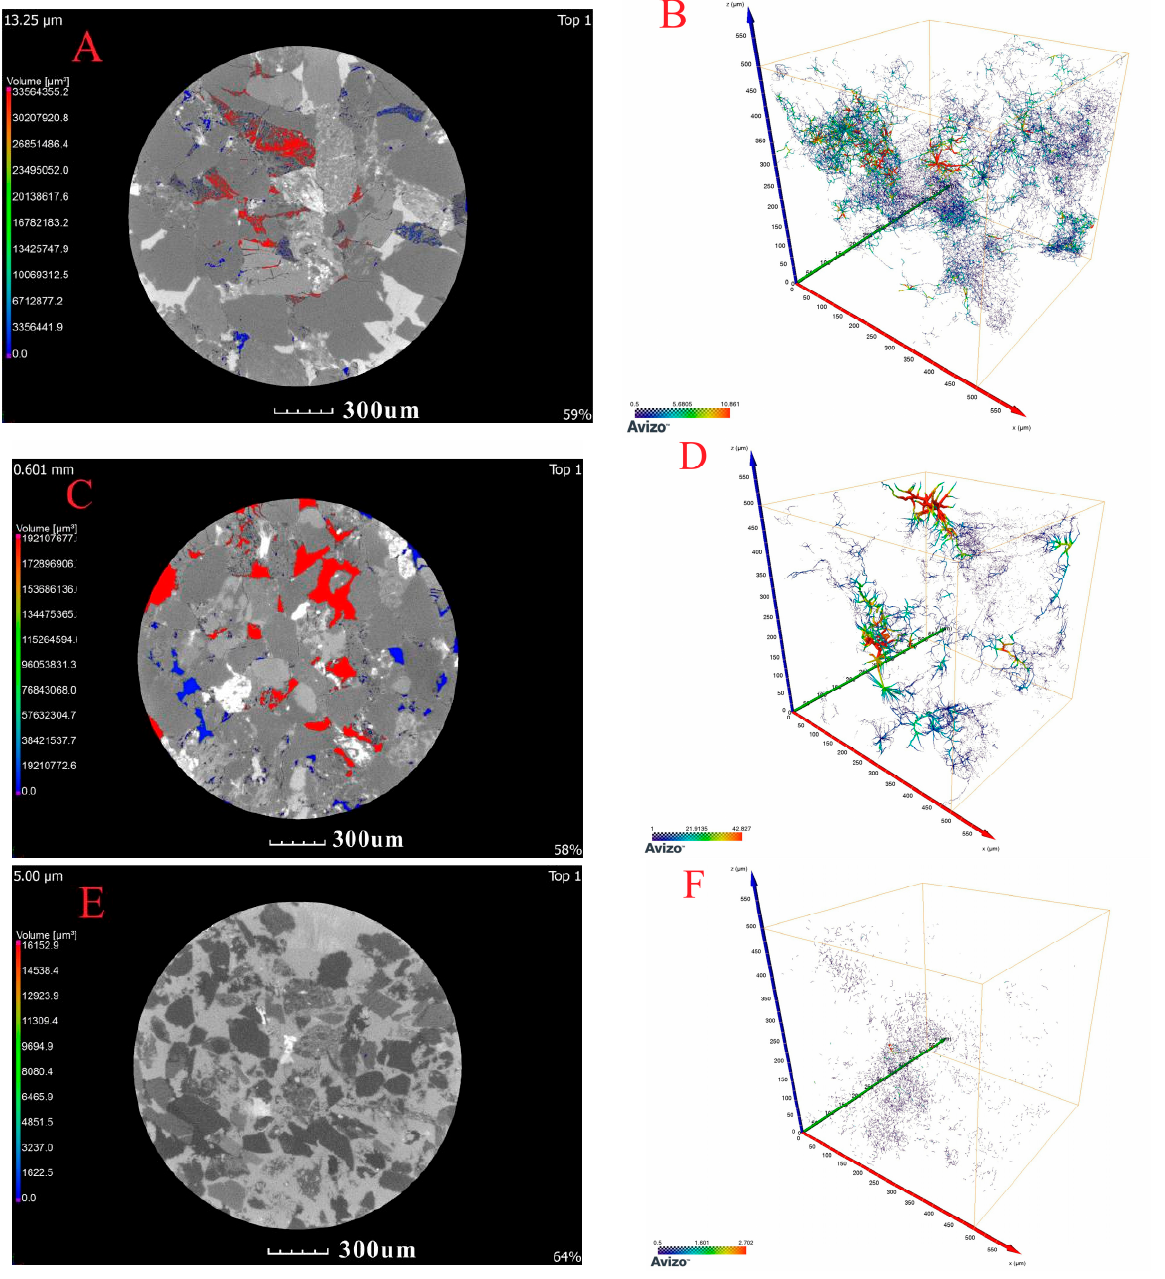
Figure 3. ( A ) Top view of pore distribution (Sample No. 1); ( B ) Three-dimensional structure model of throats (Sample No. 1); ( C ) Top view of pore distribution (Sample No. 8); ( D ) Three-dimensional structure model of throats (Sample No. 8); ( E ) Top view of pore distribution (Sample No. 10); ( F ) Three-dimensional structure model of throats (Sample No. 10); Sample Nano-CT scanning image .